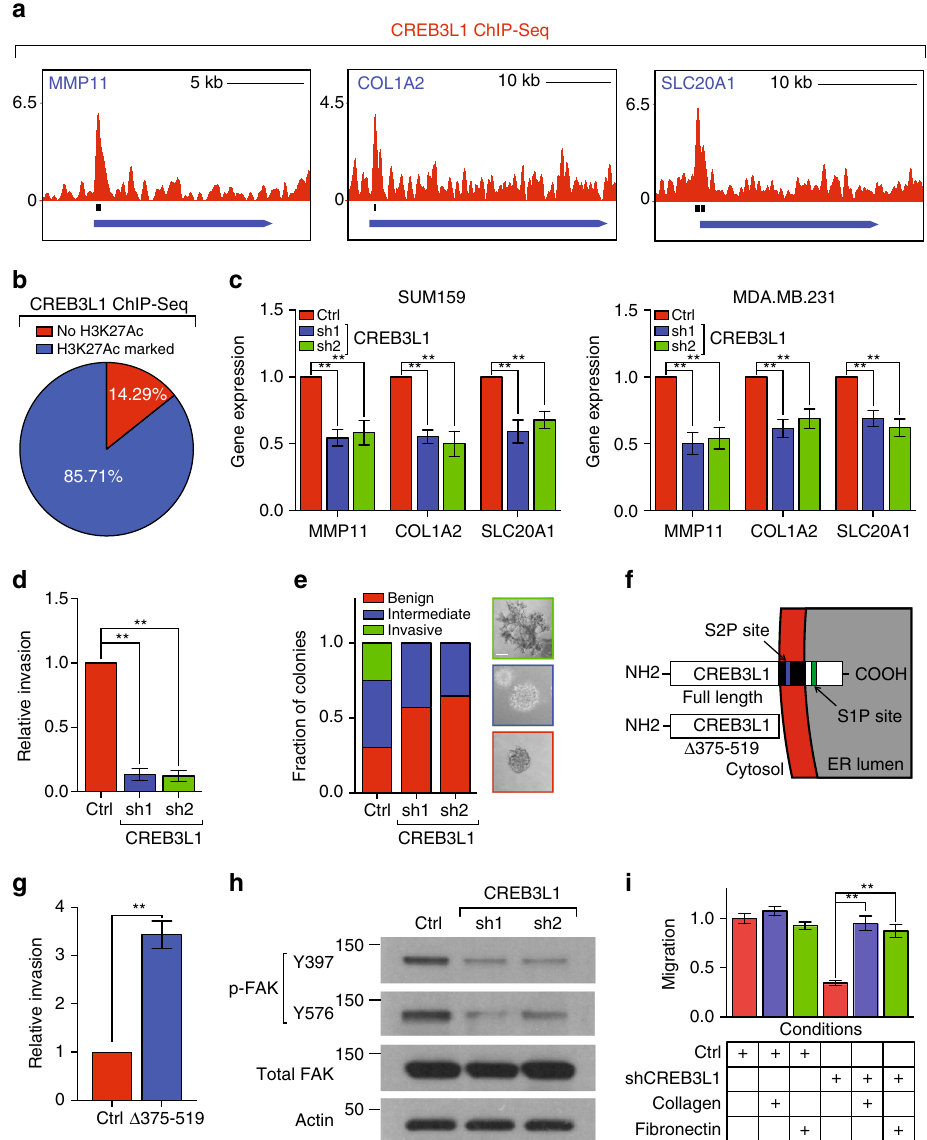
Fig. 2 CREB3L1 upregulates cancer-speci fi c PERK genes and is required for invasion. a Distribution of CREB3L1 ChIP-seq fold-enrichment over input control, along with called-peaks, at the locus of CSPS genes. Shown were the CREB3L1 peaks for three CSPS genes: MMP11, COL1A2, and SLC20A1. b A pie chart showing the fraction of CREB3L1 ChIP-Seq peaks from the CSPS genes that were co-localized with acetylated H3K27. c qPCR showing the relative expression of the CSPS genes shown in a in SUM159 and MDA.MB.231 cells transduced with shRNAs targeting luciferase or CREB3L1, n = 4. d Quanti fi cation of the cell invasion of SUM159 cells transduced with shRNAs targeting luciferase or CREB3L1 in a basement membrane-coated transwell assay, n = 3. e Left panel: quanti fi cation of colony types formed by SUM159 cells transduced with shRNAs targeting luciferase or CREB3L1 in a 7-day 3D Matrigel invasion assay, n = 50; right panel: representative images of benign, intermediate, and invasive colonies (scale bar: 80 µ m). f Schematic of full- length CREB3L1 and CREB3L1 Δ 375-519 . g Quanti fi cation of cell invasion of HMLE cells transduced with control plasmid or a constitutive active form of CREB3L1 (CREB3L1 Δ 375 – 519 ) in a basement membrane-coated transwell assay, n = 3. h Western blotting of phospho-FAK (pY397 and pY576), total FAK, and Actin in SUM159 cells transduced with shRNAs targeting luciferase or CREB3L1. i Quanti fi cation of cell migration of SUM159 cells transduced with shRNAs targeting luciferase or CREB3L1 treated with the indicated conditions, n = 8. Data are represented as mean ± SEM. * indicates p < 0.05; ** indicates p < 0.01 (Student ’ s t -test) log-rank test; Fig. 1c). Expression of these genes was also predic- (Fig. 1a, b; CSPS, cancer-speci fi c PERK set). Expression of these tive of tumor progression in lung and gastric cancers (Fig. 1d, e). genes depended on PERK activity, since inhibition of PERK with a small-molecule inhibitor (GSK2656157 14 ) led to a signi fi cant CREB3L1 upregulates CSPS genes and is required for invasion . decrease in the expression of 18 out of 23 CSPS genes (Supple- CREB3L1 was the only transcription factor among the cancer- mentary Fig. 1b). Breast cancers that highly expressed these speci fi c PERK genes we identi fi ed (Fig. 1a, b). Analysis of cancer-speci fi c PERK genes were signi fi cantly more likely to ChIP-seq data indicated that CREB3L1 was enriched near CSPS develop distant metastases over 10 years (HR = 1.8, p < 0.005, gene loci (14/23 genes, p < 0.01, binomial test; Fig. 2a and NATURE COMMUNICATIONS | 8: